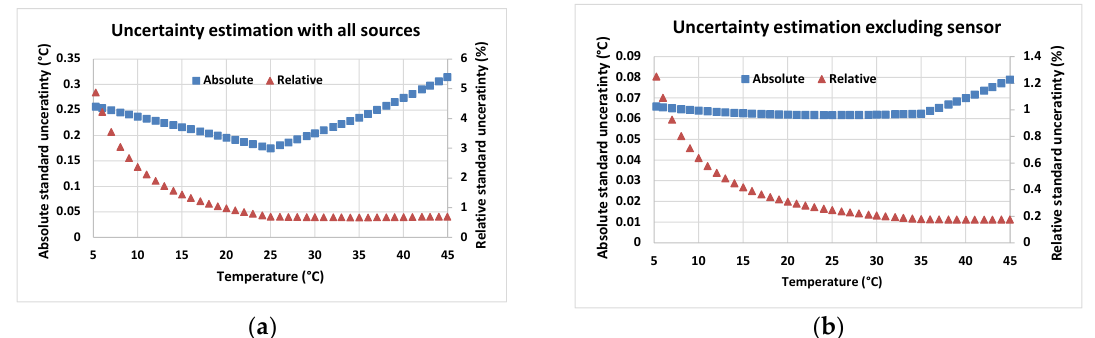
Figure 3. ( a ) Absolute and relative uncertainty estimation for temperature measurement based on system design and uncertainties of component nominal values; ( b ) uncertainty of the conditioning circuit components excluding the sensor tolerance.